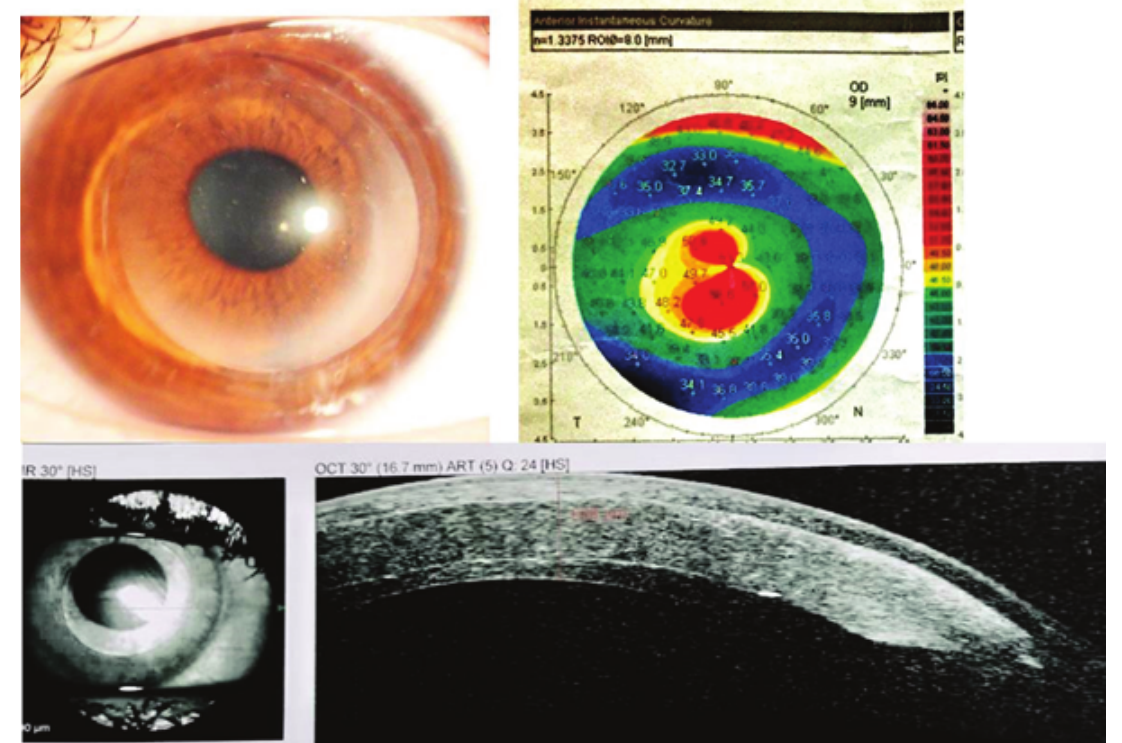
Figure 3. Preoperative topography, postoperative slit photo, and anterior OCT of patient number one. Faint haziness of visual axis without any interface wrinkling is seen 55 months after